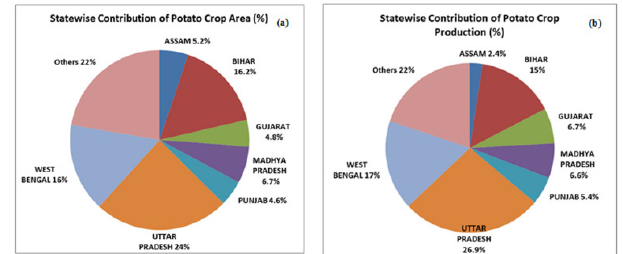
Figure 2. State-wise (2012-16) contribution to Potato (a) area and (b) Production in the country (Source: DAC&FW). Till 2013-14, potato crop was estimated at state level. Since 2104-15, potato estimation was carried out at district level.